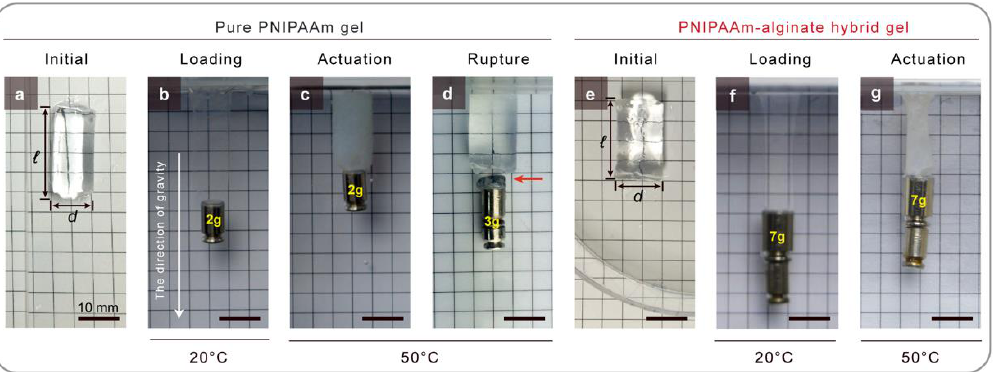
Figure 1. Active materials must be tough. ( a ) Pure PNIPAAm gel was submerged into 20 ℃ water for 1 day and cut into an initial size of ℓ = 21 mm with a cylindrical shape ( d = 10 mm). ( b ) 2 g of brass dead weight was glued to one end of the pure PNIPAAm gel, which was then hung from the ceiling. The gel was stretched by gravity in 20 ℃ water. ( c ) Pure gel with a 2 g brass dead weight was shrunk in 50 ℃ water for 1 day. ( d ) Pure PNIPAAm gels were ruptured by a 3 g brass dead weight in 20 ℃ water (arrow identifies ruptured area in the gel). ( e ) PNIPAAm – alginate hybrid gel fully swollen in 20 ℃ water for a day and cut into a test size of ℓ = 20 mm with a cylindrical shape ( d = 10 mm). ( f ) Hybrid gel capable of sustaining a 7 g brass dead weight in 20 ℃ water. ( g ) Hybrid gel showing thermal actuation against a 7 g brass dead weight in 50 ℃ water. The gel remained intact during actuation.